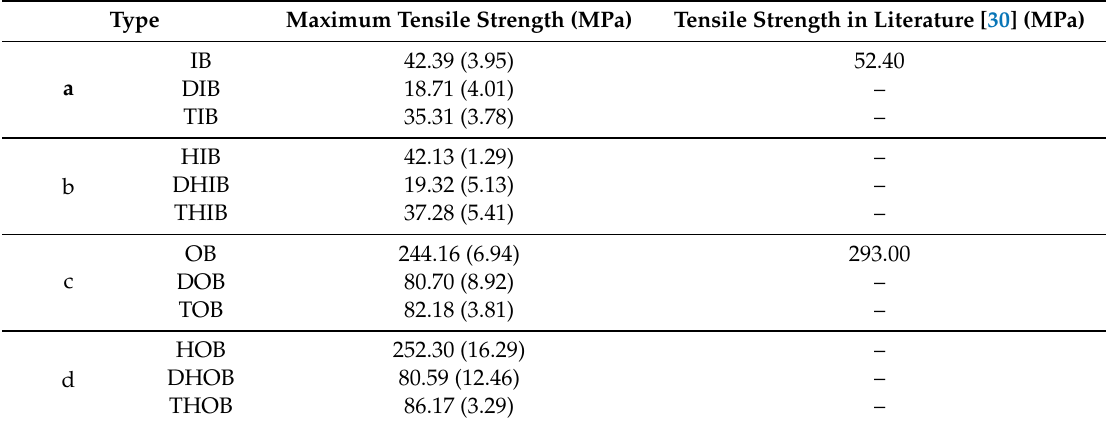
Table 2. Maximum tensile strength of the di ff erent samples.